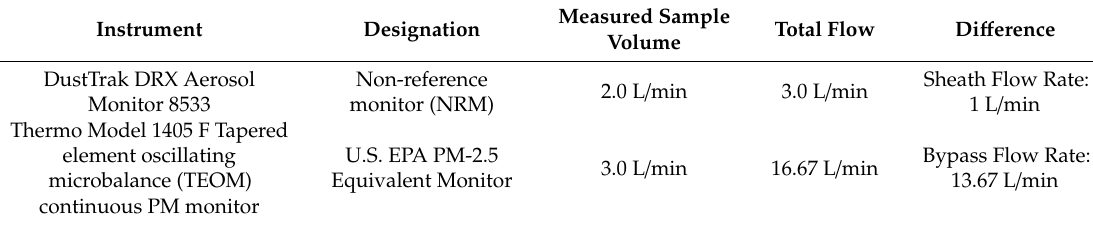
Table 2. Characteristics of the DRX and FEM monitors used for the current